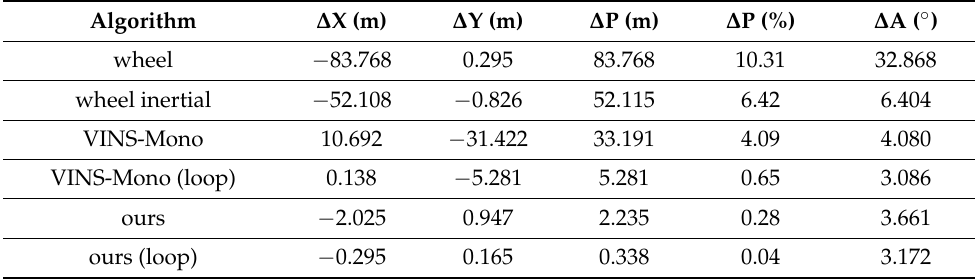
Table 2. Floor-scale pose measurements